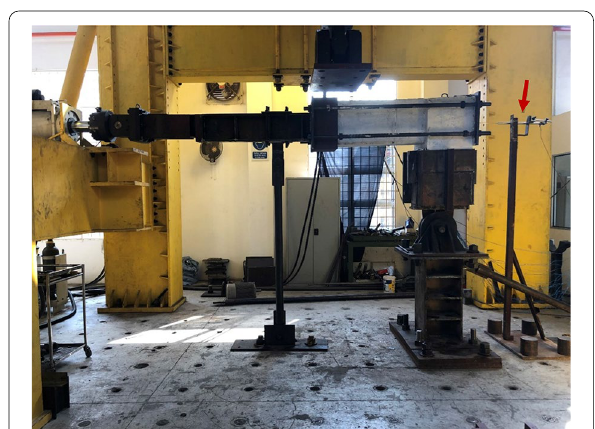
specimen during the ‘opening’ or pulling action on the knee beam–column structure which caused brittle failure below the yield design moments (Angelakos 1999). The damages caused at the inside corner subjected to com- pressive forces during closing actions were controllable because plain concrete is stronger in compression.